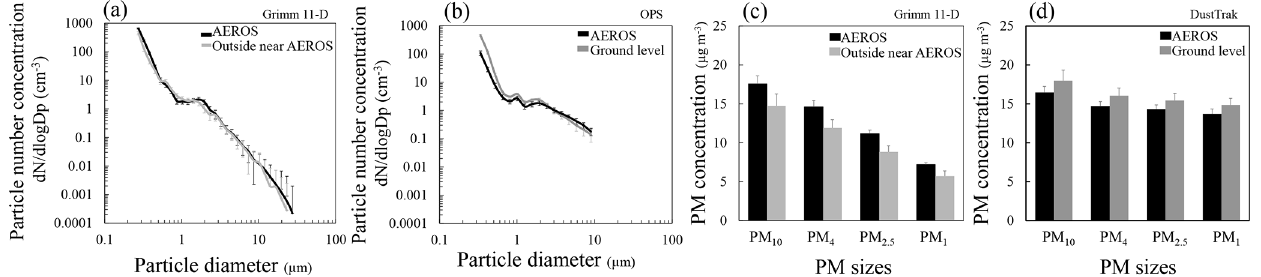
Figure 6. Comparison of measurements taken in the AEROS shed with measurements taken on the ground level or the rooftop floor outside the AEROS shed. (a) Particle size distribution (optical diameter) measured by the Grimm 11-D unit in the AEROS shed (black) and outside on the rooftop floor (light gray). (b) Particle size distribution (optical diameter) measured by the OPS in AEROS (black) and on the ground floor (dark gray). (c) PM concentration at various sizes as measured by the Grimm 11-D unit in AEROS (black) and outside AEROS on the rooftop floor (gray). (d) PM concentration at various sizes as measured by DustTrak in AEROS (black) and on the ground floor (dark gray). Error bars represent SD values of the measured period.